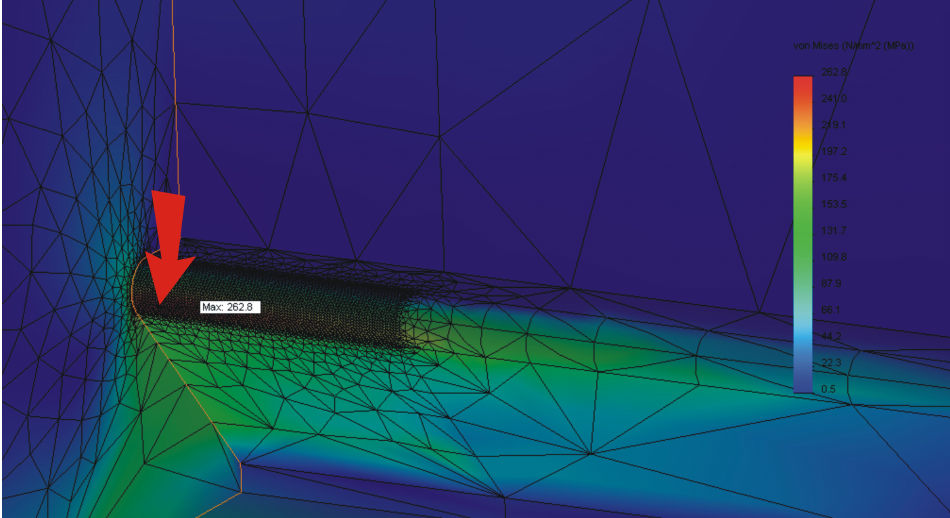
Figure 16: Stresses concentration in the dovetail coupling.